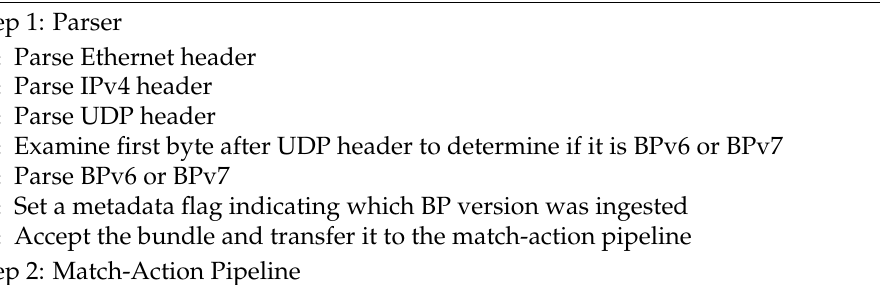
Algorithm 1 P4 Bundle Translator